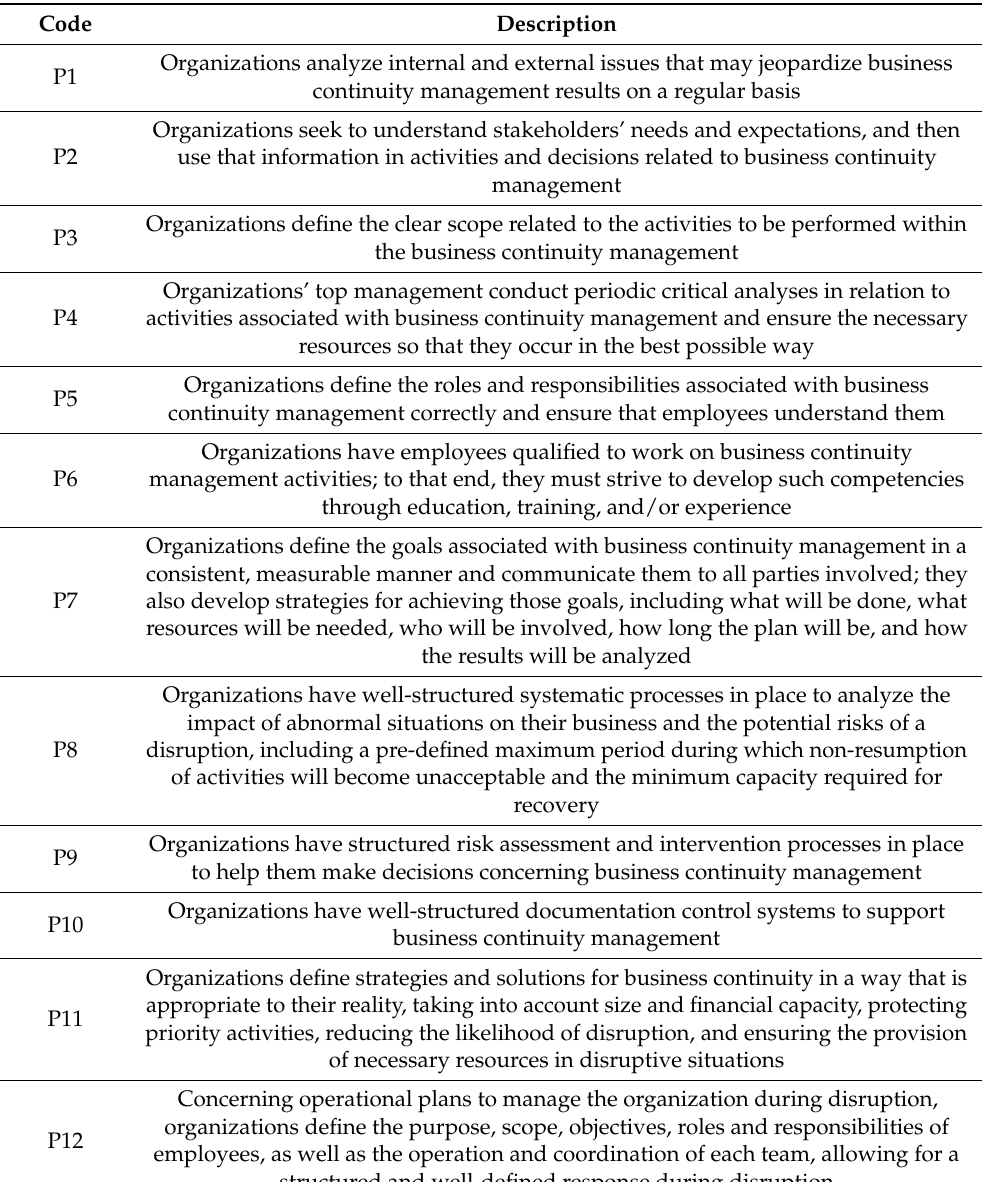
Table 1. The business continuity management practices that comprised the